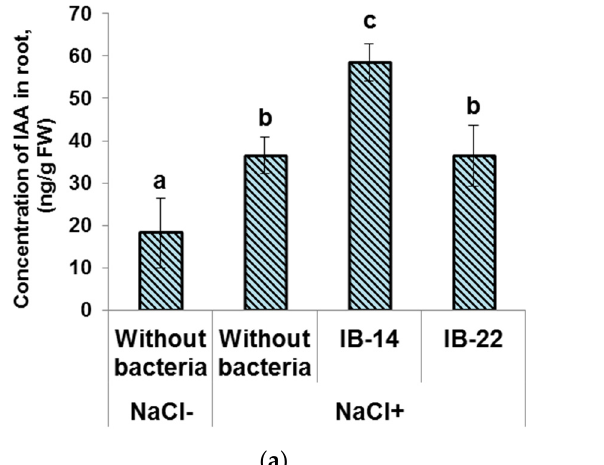
Figure 2. Effect of 100mM NaCl and bacterial treatment with Pseudomonas mandelii IB ‐ Ki14 (IB ‐ 14) and Bacillus subtilis IB ‐ 22 (IB ‐ 22) on cytokinin concentration in the roots ( a ) and in the shoots ( b ) of 6 ‐ day ‐ old wheat plants. Data are means ± SE. Significantly different means are labeled with different letters at p ≤ 0.05, n = 6 (ANOVA followed by Duncan’s test).